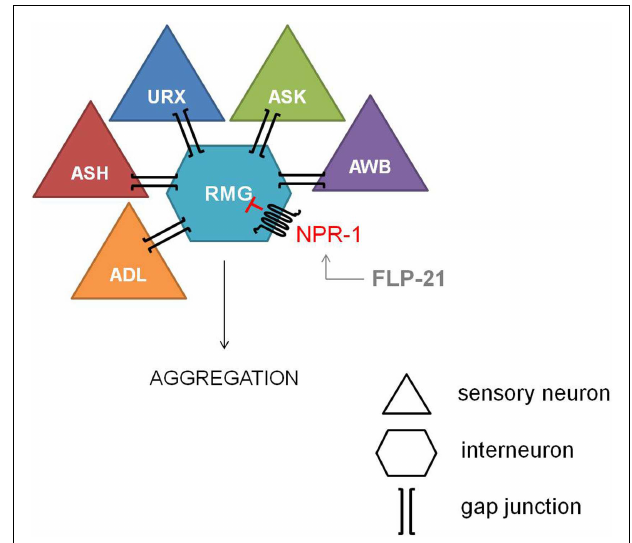
FIGURE 2 | Inhibiton of the RMG inter/motor neuron by NPR-1. The RMG neuron is the hub of a gap junction network connecting the ADL, ASH, URX, ASK, and AWB sensory neurons, which are known to trigger aggregation. NPR-1 inhibits this gap junction driven activation of RMG (figure adapted from Macosko et al.,